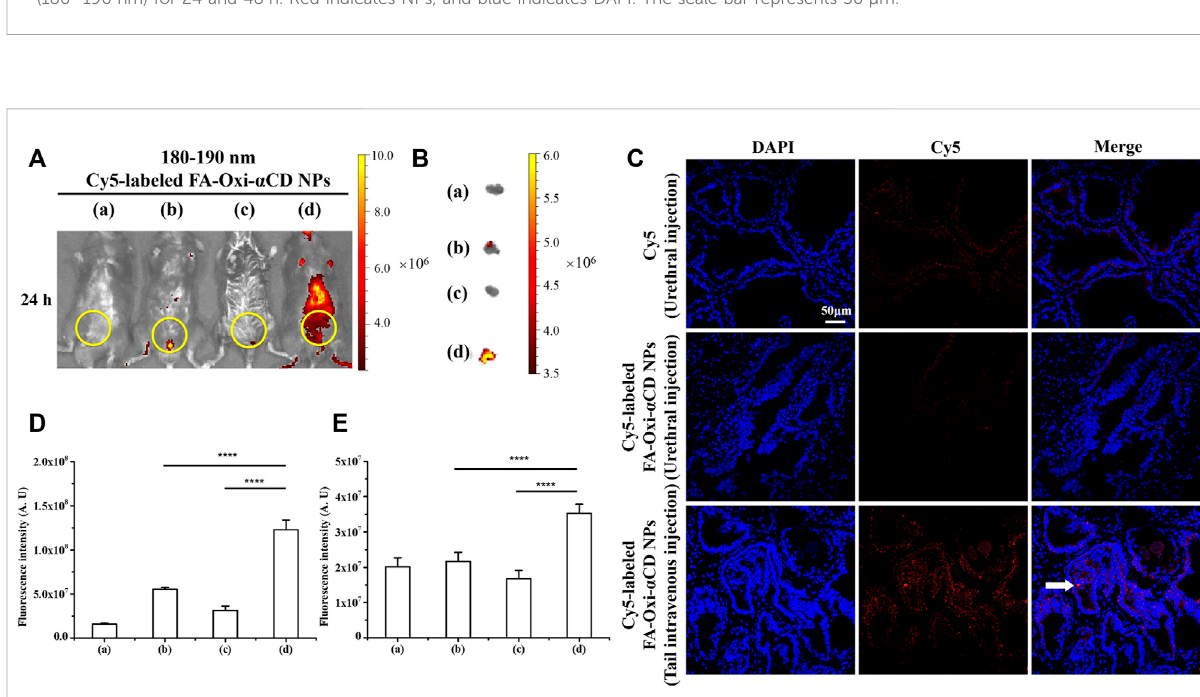
FIGURE 8 Effect of injection mode on NPs targeting in fl ammatory prostate tissue. (A) In vivo fl uorescence images of (a) saline, (b) free Cy5 (Urethral injection),(c)Cy5-labeledFA-Oxi- α CDNPs(Urethralinjection)and(d)Cy5-labeledFA-Oxi- α CD(Tailintravenousinjection)inamurinemodelofCBP at 24 h after intravenous injection (the region in the yellow circle indicates the lower urinary tract and part of the reproductive system). (B) Ex vivo fl uorescenceimagesoftheexcisedprostatesat24 hpostinjection. (C) CLSMimagesofprostatetissuestreatedwithCy5orCy5-labeledNPsfor 24 h. Red indicates NPs, and blue indicates DAPI. The scale bar represents 50 μ m. (D) ROI analysisof fl uorescence intensity inthe lower urinary tract andpartofthereproductivesystemwasperformedat24 hafterintravenousinjection(n=3pergroup). (E) ROIanalysis ofthe fl uorescence intensity of the excised prostate at 24 h ****, signi fi cantly different at p <